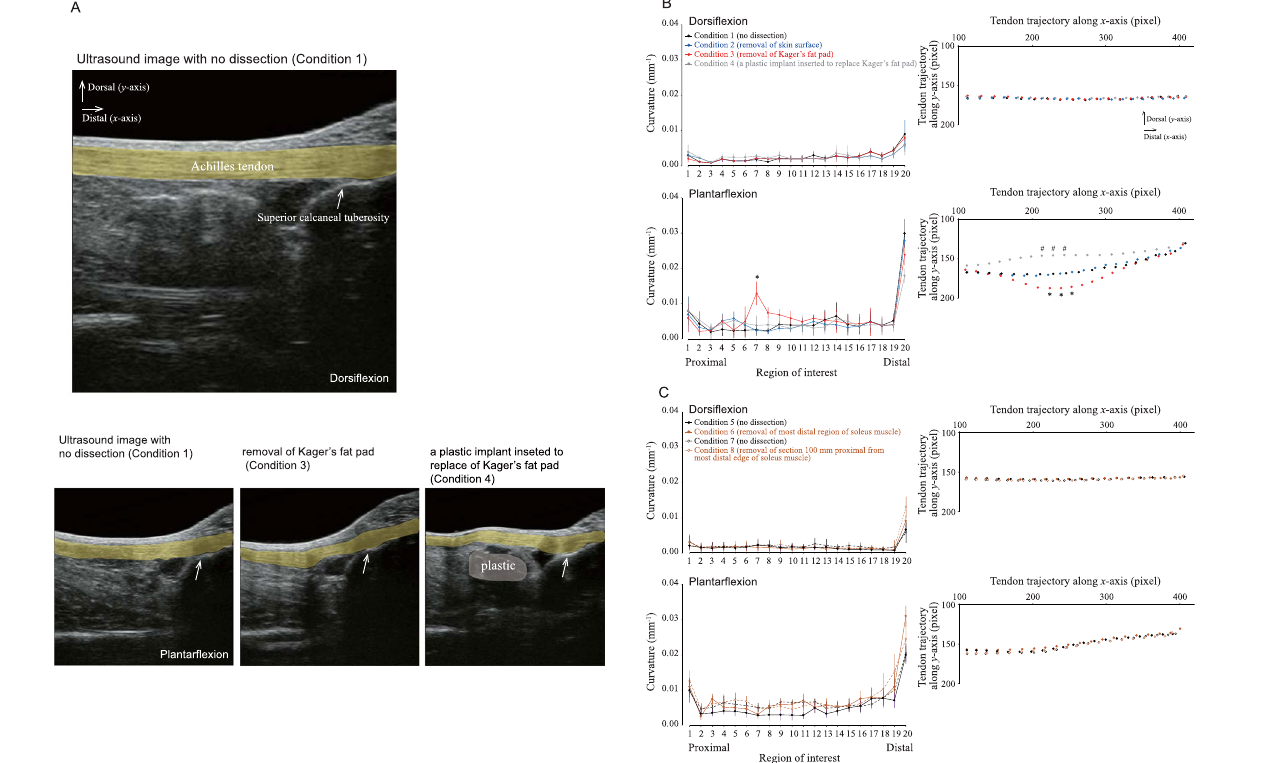
Figure 2. Effect of different dissections of the lower leg on the curvature and trajectory of the Achilles tendon in Thiel-embalmed human cadavers. ( A ) Representative sagittal longitudinal B-mode ultrasound images of the lower leg. The Achilles tendon is highlighted by a thick yellow line. The white arrow indicates the position of the superior calcaneal tuberosity, while the blue region indicates a plastic material (right bottom). ( B ) For the Kager’s fat pad dissection trial, the Achilles tendon curvature (left panel) and trajectory (right panel) is compared among four conditions (described in top-left sub-panel) during dorsiflexion and plantarflexion. The differences in the curvature and trajectory of the Achilles tendon were tested with a two-way (four dissection conditions × 20 regions of interest) ANOVA with repeated measures. Each data point represents the mean and SD of 7 legs. # indicates a significant difference ( P < 0.05) between condition 4 vs. conditions 1, 2, and 3; * indicates a significant difference ( P < 0.05) between condition 3 vs. conditions 1, 2, and 4. ( C ) For the soleus muscle dissection trial, the Achilles tendon curvature (left panel) and trajectory (right panel) is compared among four conditions during dorsiflexion and plantarflexion. The differences in the curvature and trajectory of the Achilles tendon were tested with a nonparametric Friedman two-way (four dissection conditions × 20 ROIs) ANOVA. Each data point represents the mean and SD of six subjects each for conditions 5–6 and conditions 7–8,